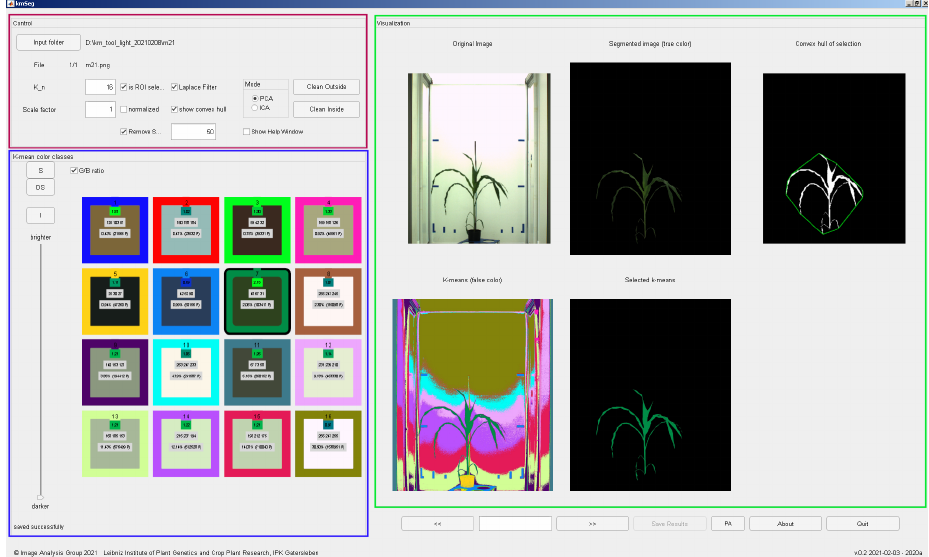
Figure 6. Graphical user interface of the kmSeg tool including three major GUI elements: the ’Control’ (magenta frame), ’k-means color classes’ (blue frame) and ’Visualization’ (green frame) areas. The example shows segmentation of a side-view maize image by selecting only one single k-means color class (icon no. 7) out of totally 16 in the ’k-means color classes’ area.